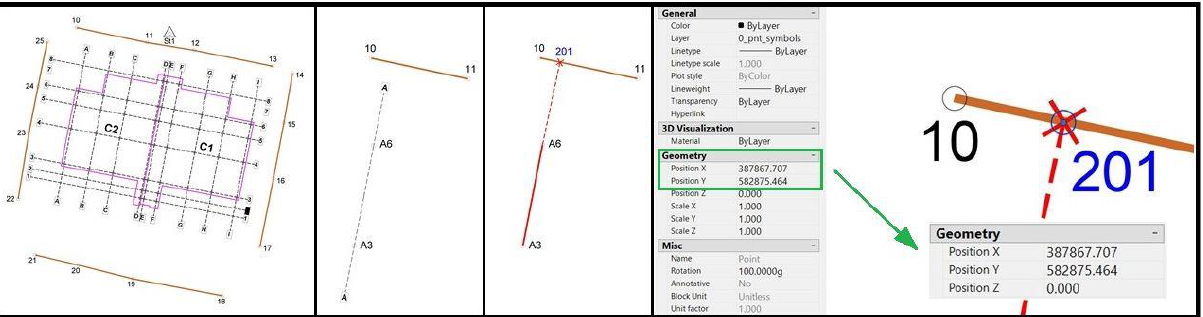
Figure 12. Intersection coordinate extraction.